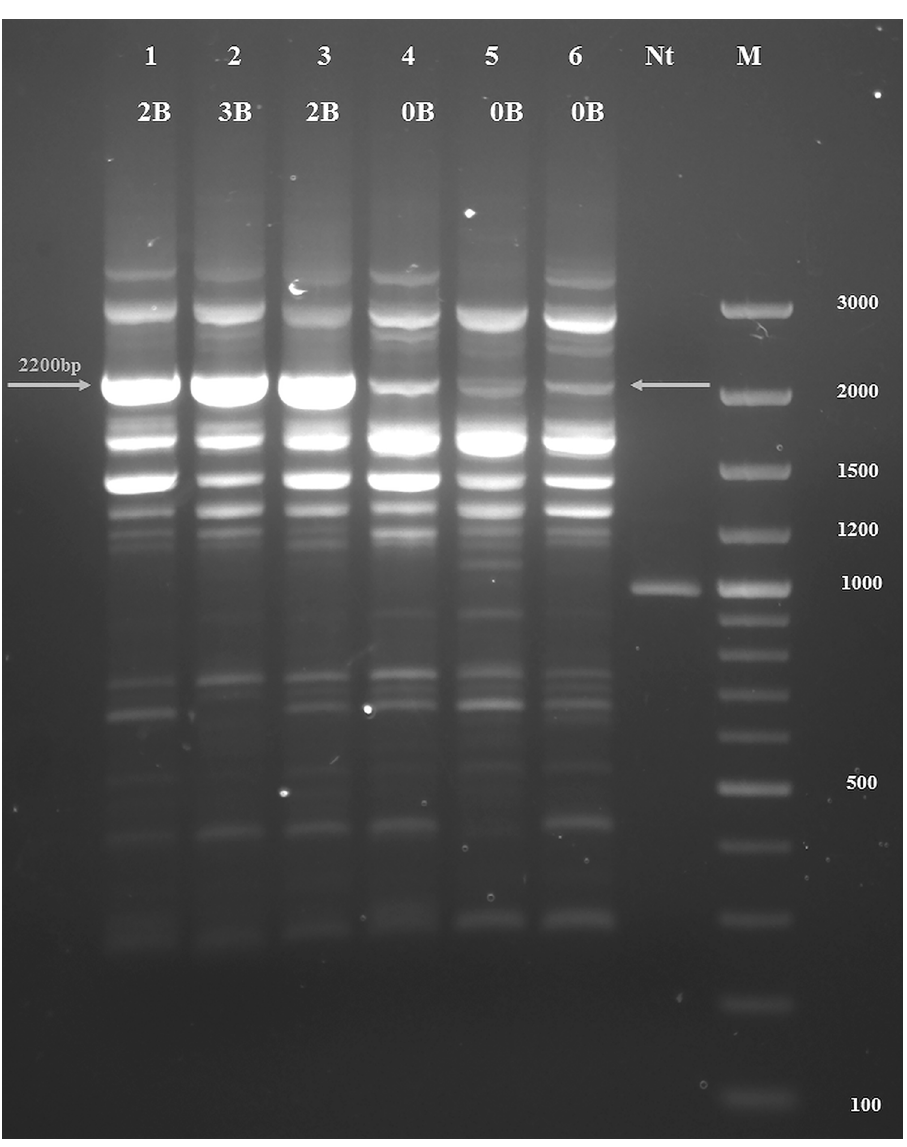
Fig 2. Electrophoretic scan of ISSR profiles amplified with primer (CAG) 4 AC. Lines 1, 2 and 3 obtained by +B gDNA; lines 4, 5 and 6 by 0B. Nt- negative control, M- GeneRuler 100 bp DNA Ladder Plus, Thermo